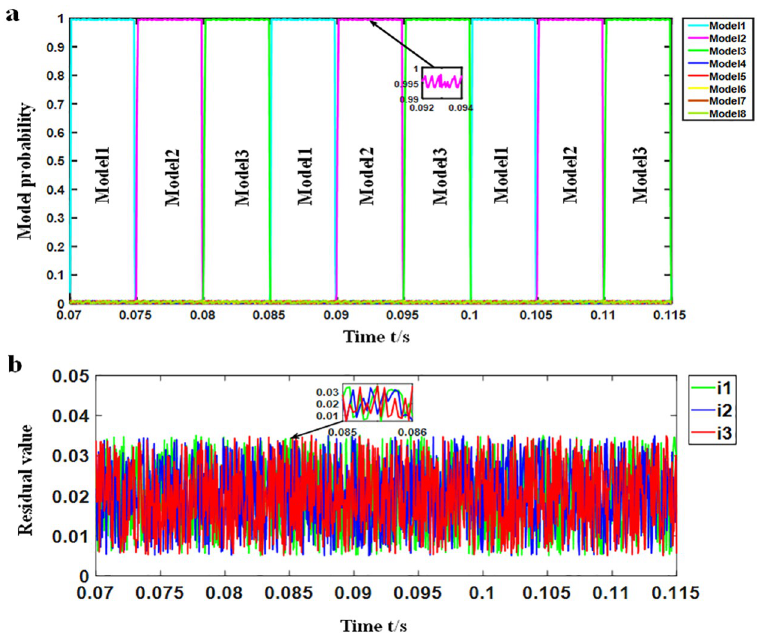
Fig 9. Simulation waveform at low speed. (a) Probability change waveform of each model (b) Current residual waveform of each.